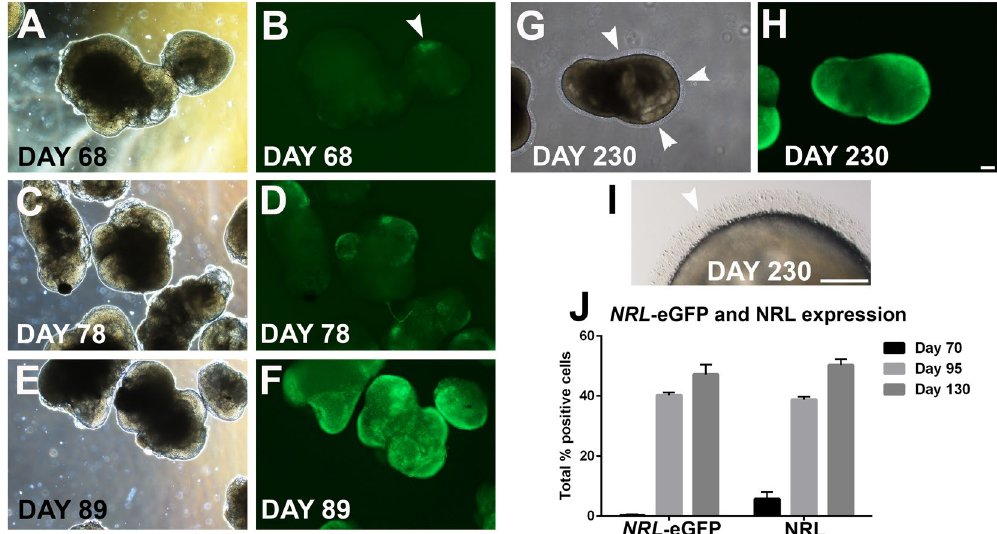
Figure 3. Observing rod production in live NRL + /eGFP OVs. Phase and epifluorescence images of live NRL + /eGFP OVs were obtained over time in live cultures. ( A , B ) Small patches of NRL -eGFP were detected beginning at d68 (arrowhead in B ). ( C–F ) NRL -eGFP fluorescence increased from d78 ( C , D ) to d89 ( E , F ), by which time all OVs demonstrated robust NRL -eGFP fluorescence. ( G , H ) NRL -eGFP fluorescence is maintained to at least d230, the last time point examined. ( G,I ) Hair-like outer segment projections are formed along the outside of OVs (arrowheads). ( J ) To quantify the number of NRL -eGFP + and NRL + cells, dissociated